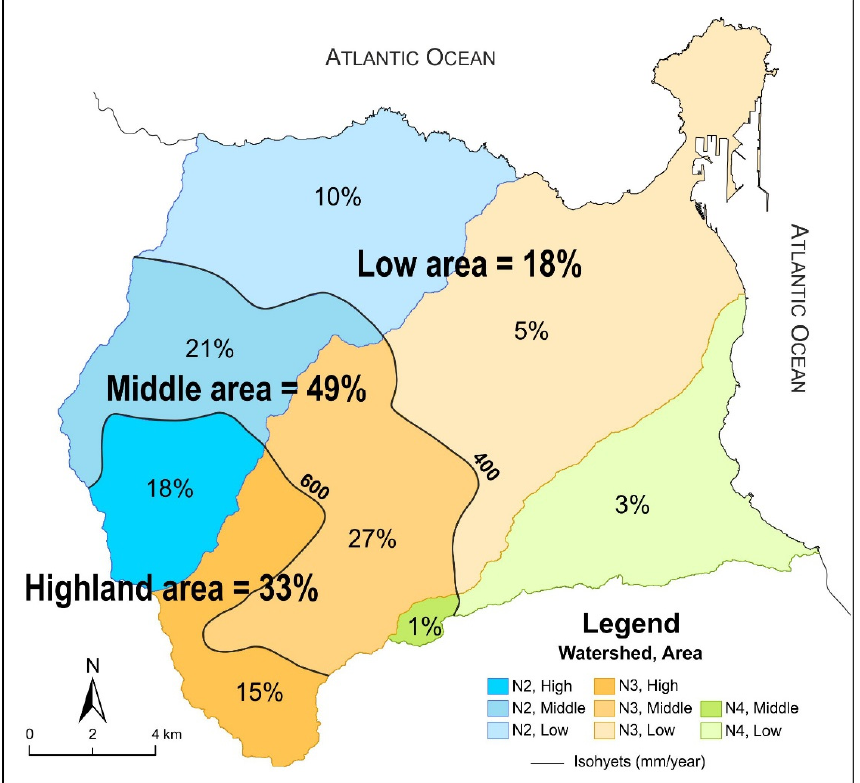
Figure 7. Fraction of the estimated average recharge in each subarea to total estimated recharge for all three studied watersheds (the whole study area) as a percentage. Small figures refer to each considered subarea and large ones to the respective hydrological zone